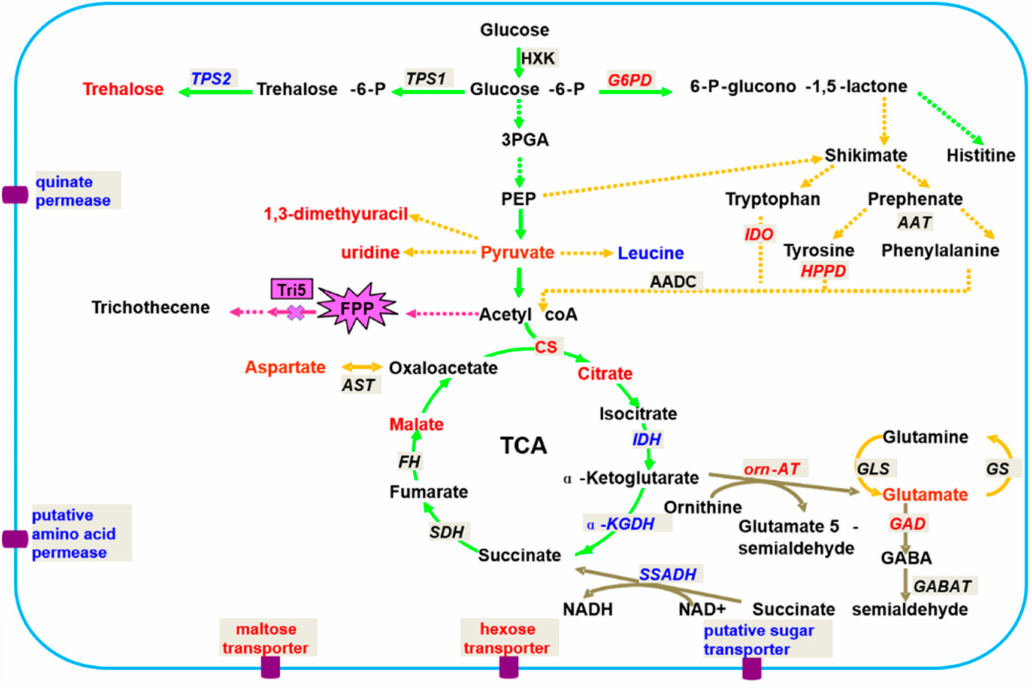
Figure 2. Hypothetical network of metabolism in F. graminearum related to 5035 / Tri5 . Red font indicates significantly up-regulated metabolites ( r > 0.75); blue font indicates significantly up-regulated metabolites ( r > 0.75); black font indicates metabolites detected but with low cuto ff values ( r < 0.75) or not detected in this study; the green pathway indicates C metabolism; the orange pathway indicates N-metabolism; maroon indicates the GABA shunt; the textbox with a French grey background indicates the code genes in the metabolism, the red and blue fonts indicate the significantly up / down-regulated trends, and the black font indicates no changes in the trends; significant metabolites are shown by an explosive shape. Abbreviations: 3-PGA, 3-phosphoglycerate; PEP, phosphcenolpyruvate; TCA, tricarbocylic acid cycle; FPP, farnesyl